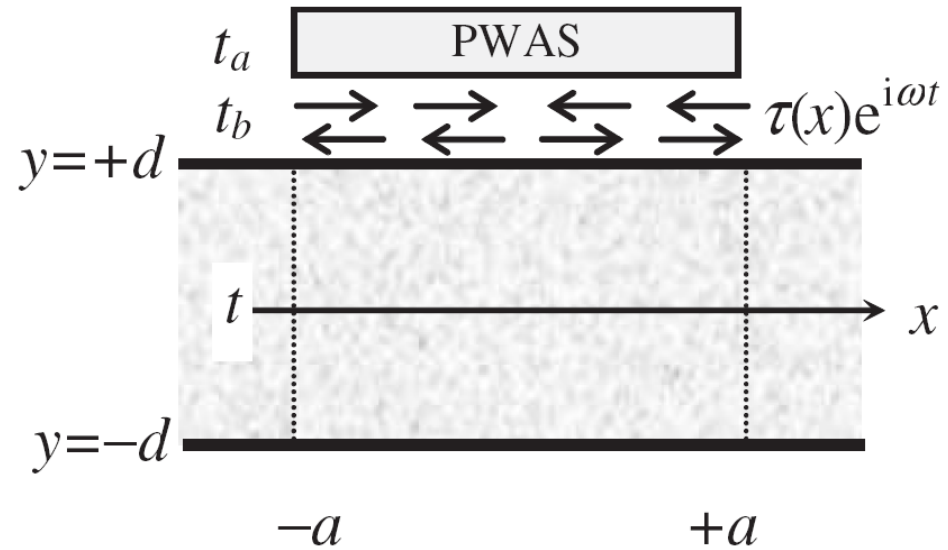
Figure 1. Illustration of a piezoelectric wafer actuator bonded to the host structure. Taken from Giurgiutiu